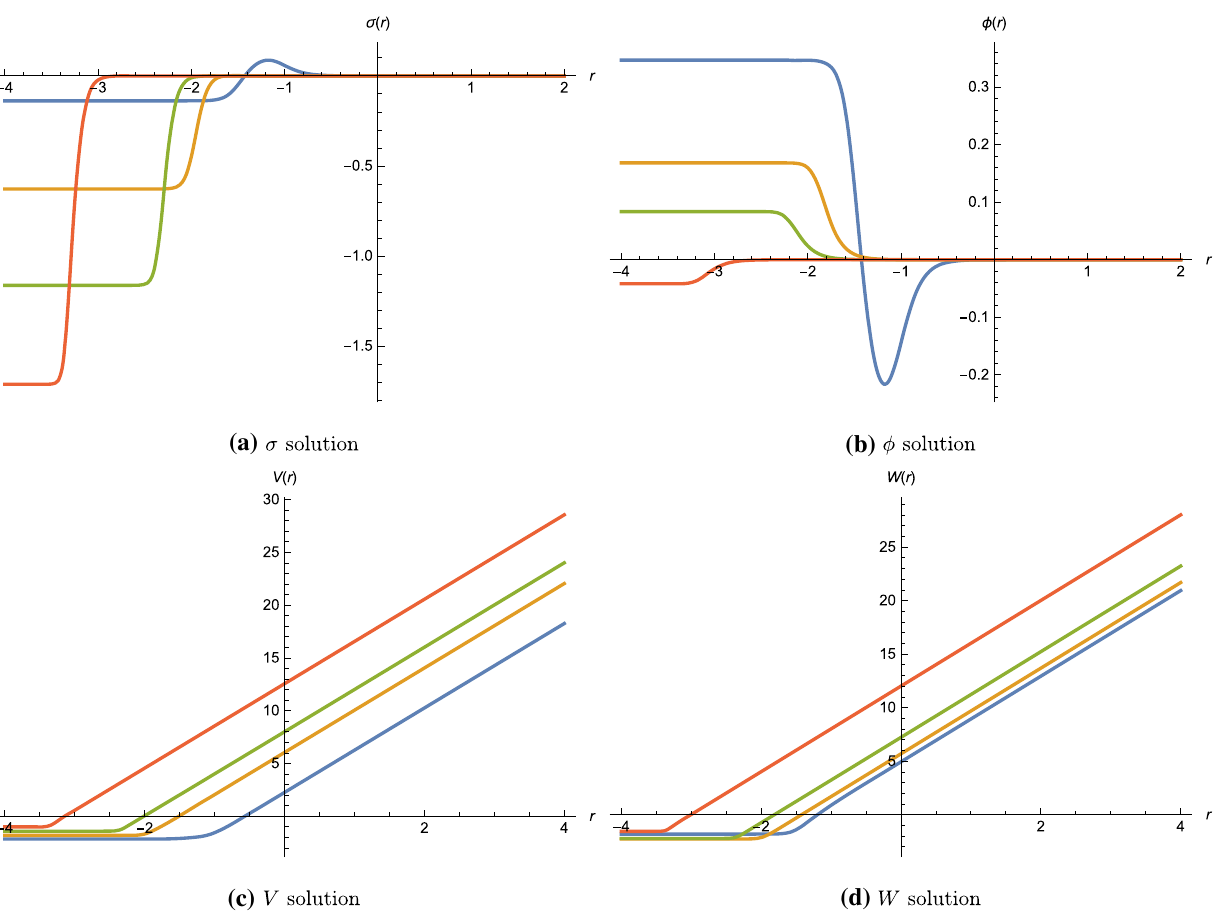
Fig. 3 RG flows from SO ( 4 ) N = ( 1 , 0 ) SCFT in six dimensions to two-dimensional N = ( 2 , 0 ) SCFTs with SO ( 2 ) × SO ( 2 ) symmetry dual to AdS 3 × H 2 × R 2 solutions for ( p 21 , p 22 ) = ( 1